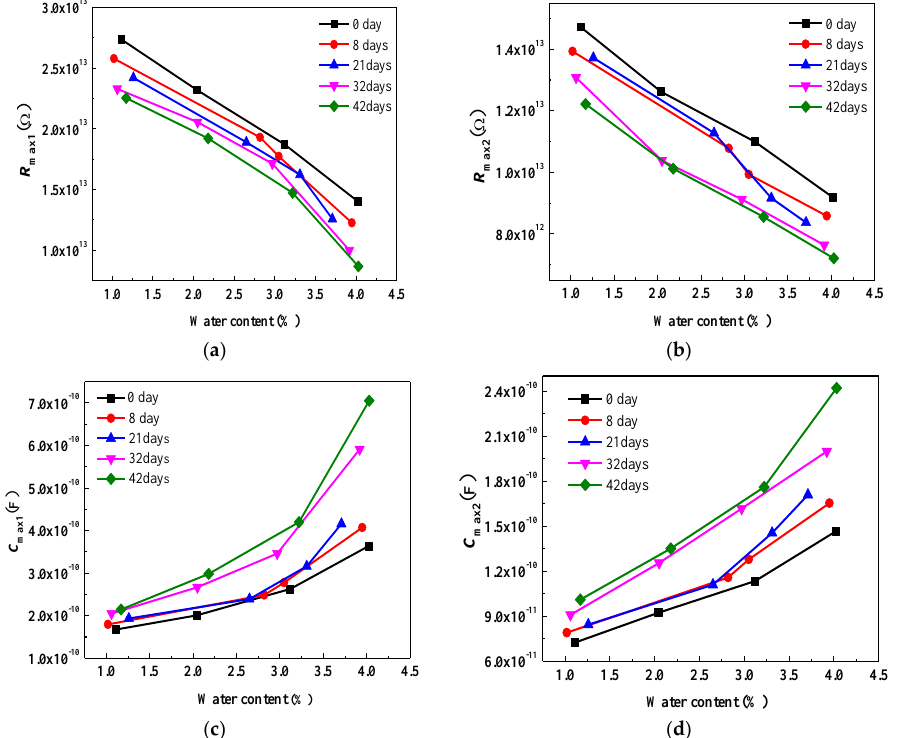
Figure 11. Resistances and capacitances of maximum and second maximum R - C branches with different water contents. ( a ) R max1 ; ( b ) R max2 ; ( c ) C max1 ; ( d ) C max2 .